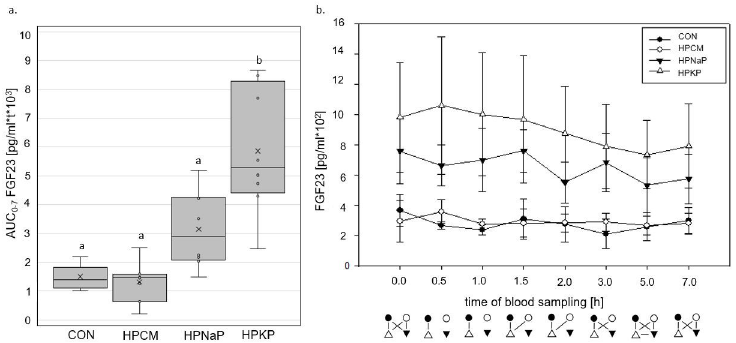
Fig 3. Serum FGF23 concentrations. a . Area under the curve from 0 until 7 hours postprandially (AUC 0-7 ) of FGF23 [pg/ml � t � 10 3 ] in adult dogs fed a control and 3 different high P diets for 18 days. Boxes not sharing a superscript letter are significantly different (p < 0.05) b . Kinetics from 0 to 7 hours postprandially of FGF23 [pg/ml] in adult dogs fed a control and 3 different high P diets. Connected symbols below the graph are significantly different (p < 0.05) at the corresponding time point. Values for healthy dogs, according to literature: 315 (211–449) pg/ml [67].